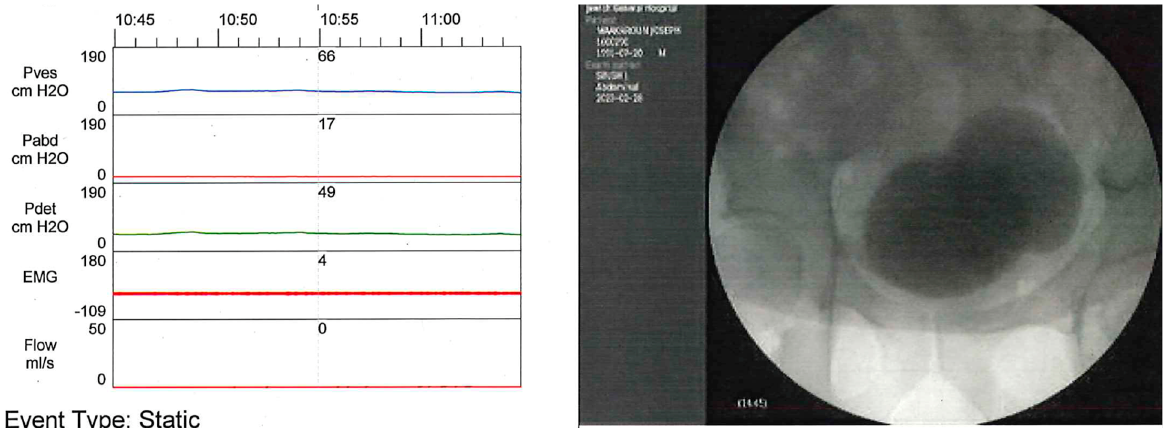
Figure 1. During the voiding phase of a VUDS, the fl uoroscopic imaging allows us to identify a large bladder diverticulum, which results from a bladder neck obstruction (the urethra doesn’t fi ll with contrast). The detrusor contraction is normal (Green line) but the patient isn’t able to void (Orange line).